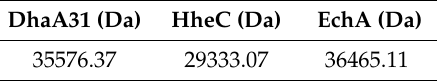
Table A5. Mass values of enzymes.